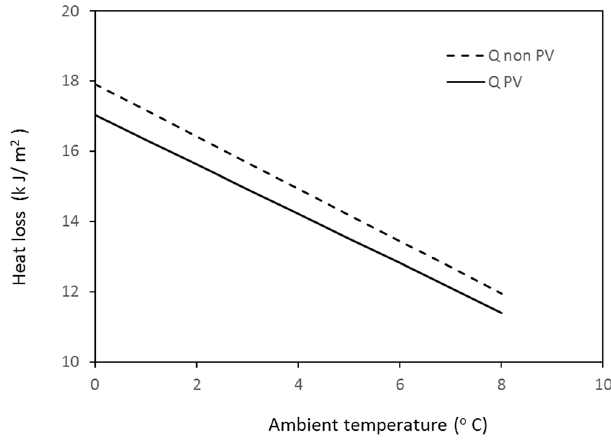
Figure 3. The effect of ceiling insulation’s thermal resistance on the heat loss from a PV, non-PV, and PV/thermal collector gabled roof at irradiation of 500 W/m 2 , a wind speed of 3 m/s, and an ambient temperature of 10 ◦ C.